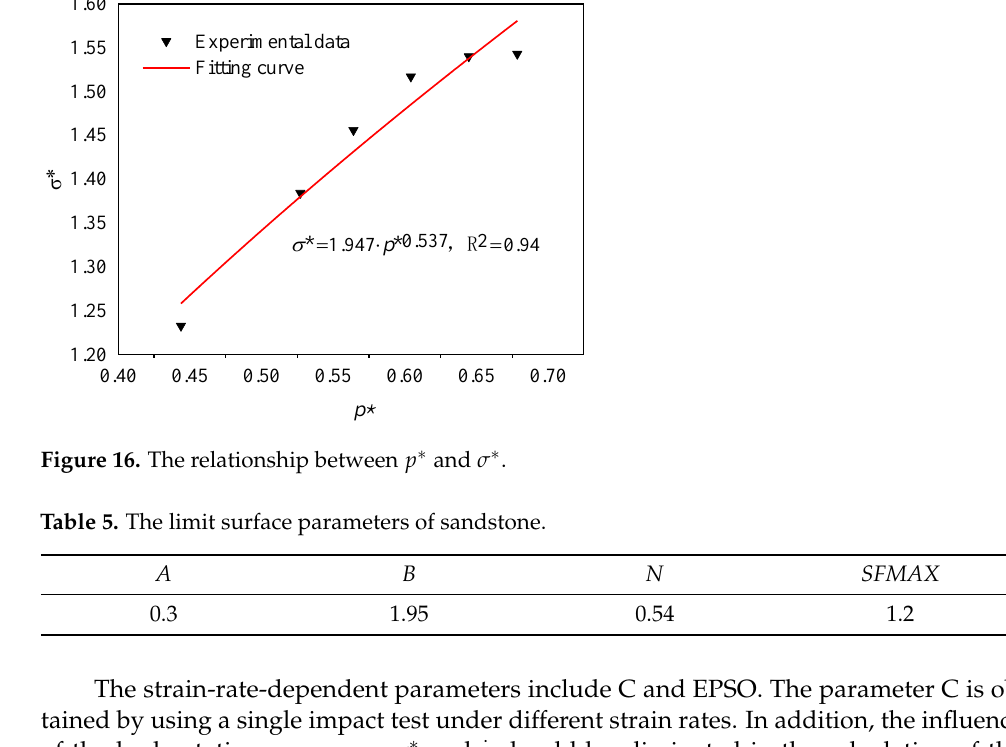
Table 5. The limit surface parameters of sandstone.